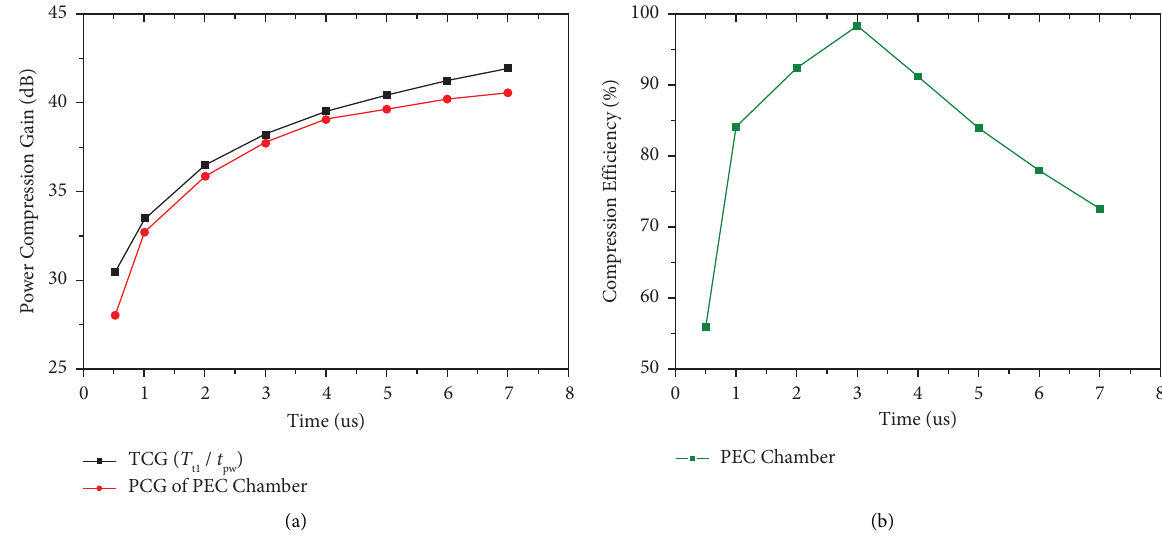
Figure 5: Te simulated pulse compression performance along with the time length of the input pulse for the rectangular reverberation chamber with PEC material. (a) Comparison of the TCG and PCG along with the time length of the input pulse. (b) Te simulated variation of the CE along with the time length of the input